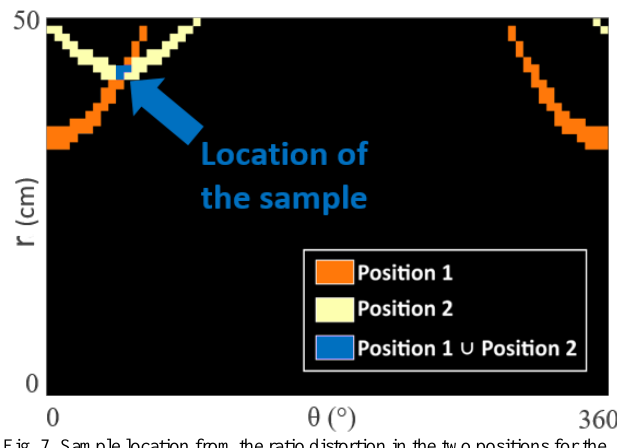
Fig. 7. Sample location from the ratio distortion in the two positions for the DU